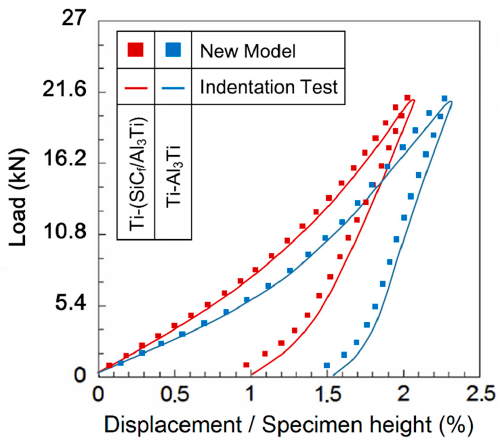
Figure 17. Results of the compressive load-strain curves solved with the 3D SAM model and indentation test under a spherical indenter.